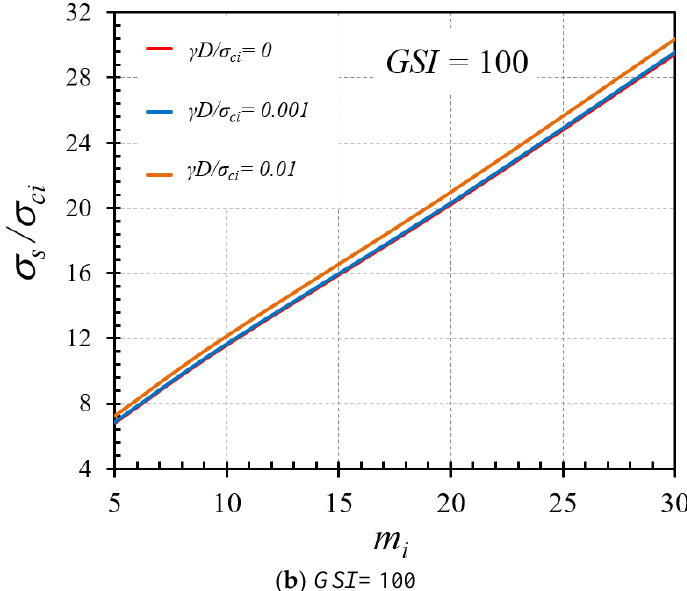
Figure 13. Impact of m i on the stability solutions of tunnel headings ( C/D = 5 and P/D = 2).